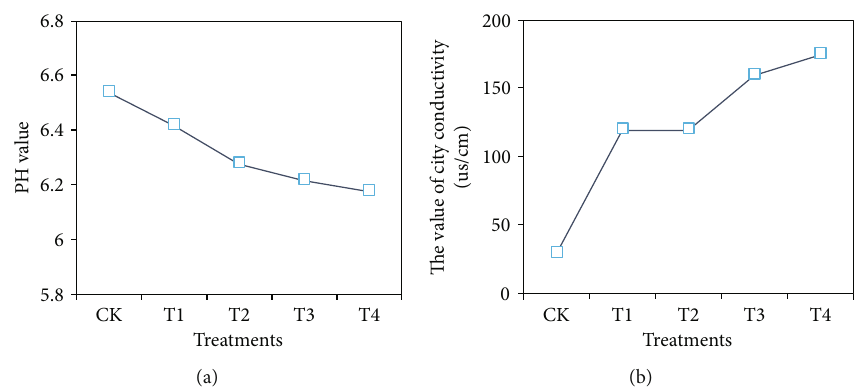
Figure 3: pH value (a) and EC value (b) of willow root exudate.